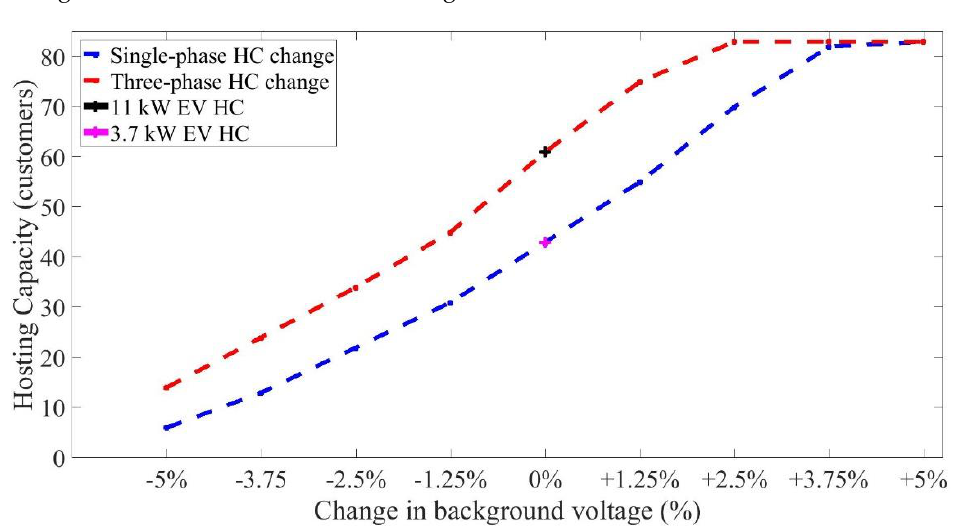
Figure 8. EV hosting capacity change for single-phase (3.7 kW) and three-phase (11 kW) charging with change in the lowest background voltage from +5% to −5 %.